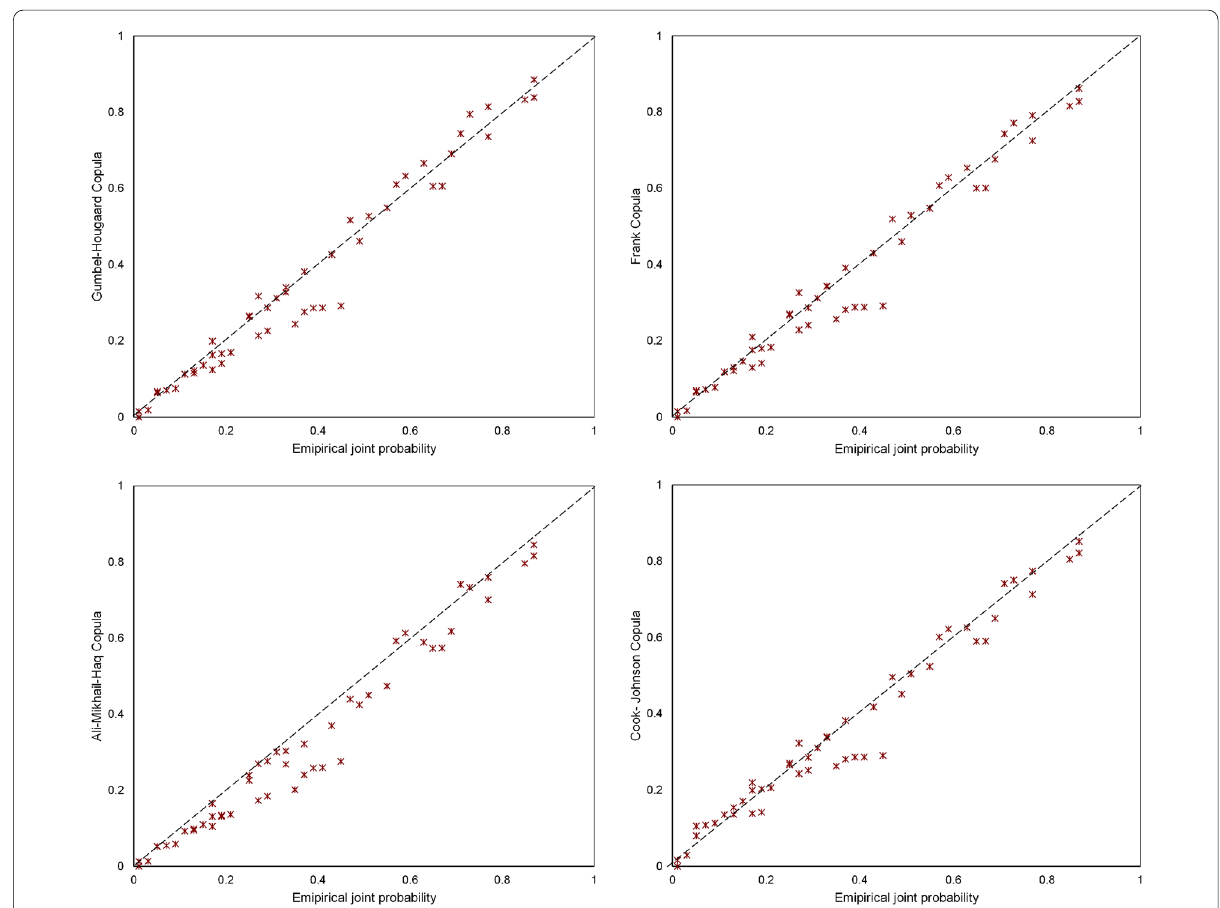
Fig. 8 Comparison of joint cumulative probabilities obtained through empirical equation and copula for flood duration and